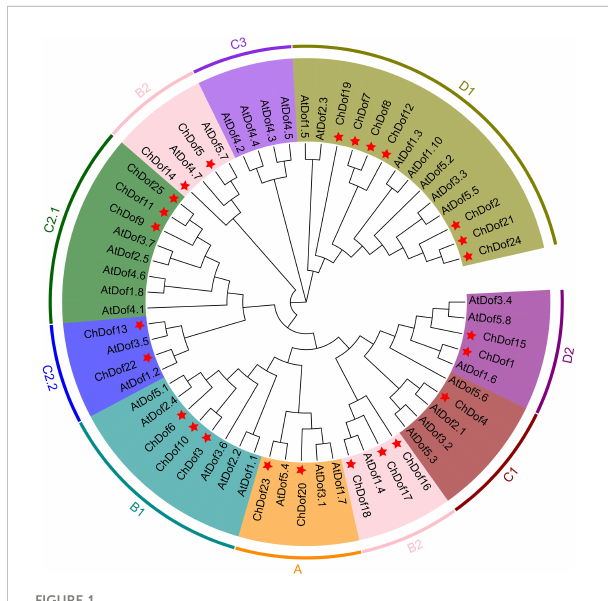
FIGURE 1 Phylogenetic analysis of Dofs in Arabidopsis and C. humilis by NJ tree. The tree include 37 Dofs from Arabidopsis thaliana , 25 Dofs from C. humilis , and construction was based on the full-length protein